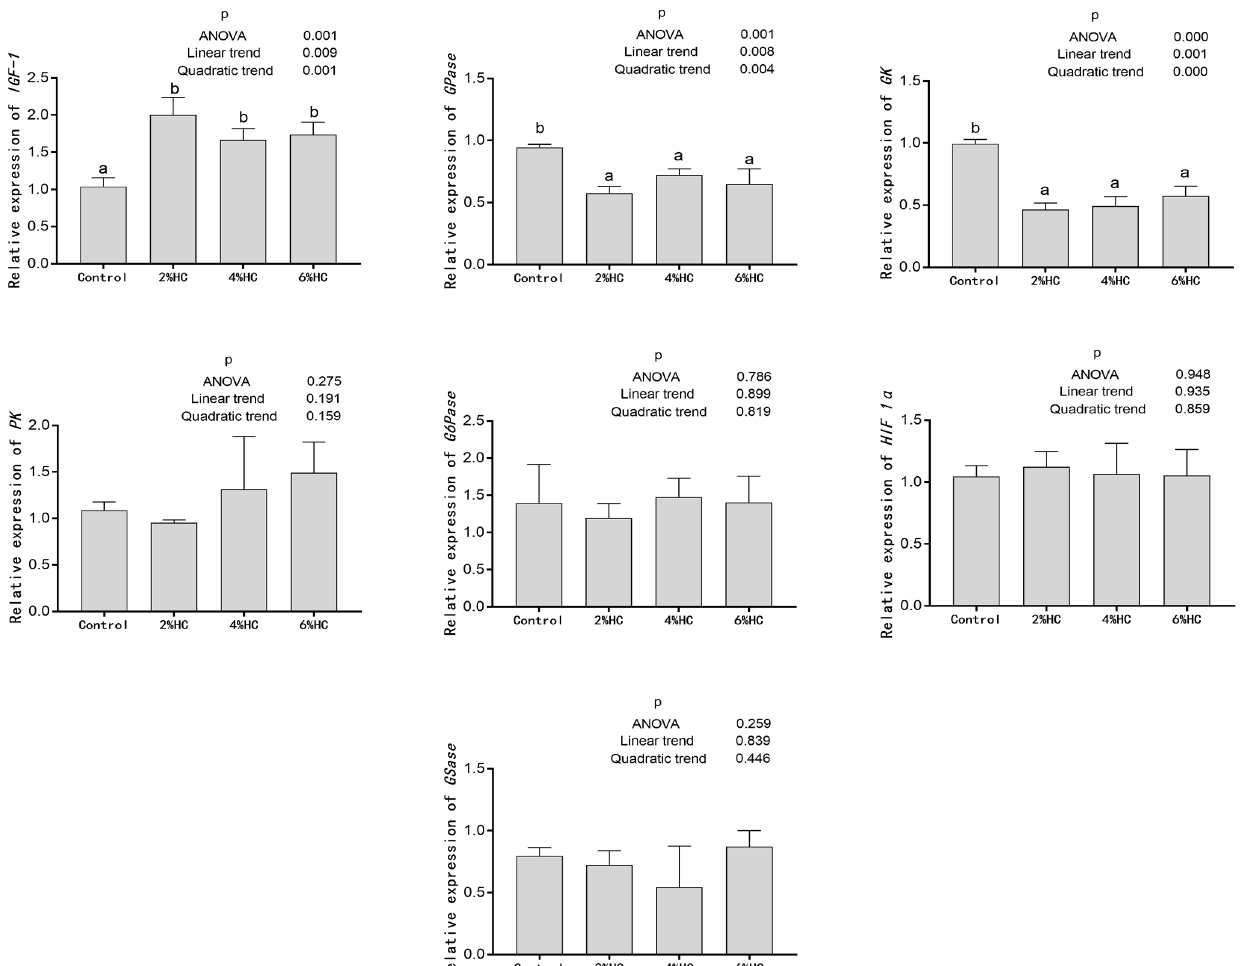
Figure 2. Effects of hydrolyzed collagen replacing fish meal on the expression levels of genes related to glucose metabolism in liver of triploid crucian carp. Values are presented as mean ± SE ( n = 3). Different letters indicate significant differences ( p < 0.05).